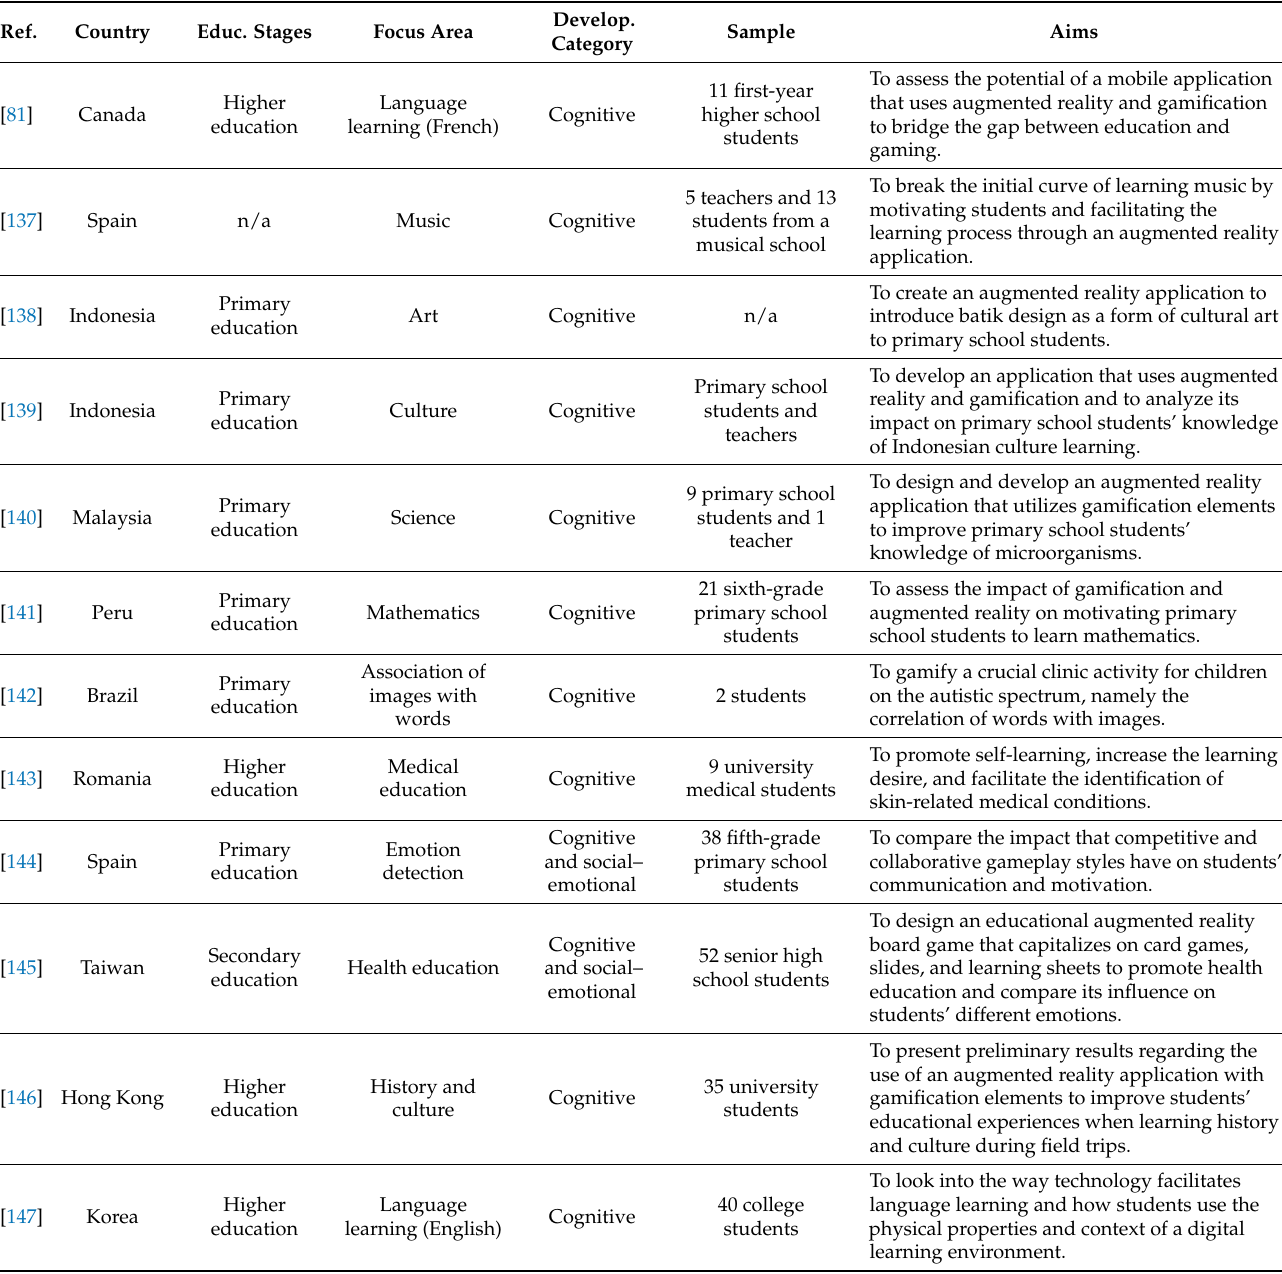
Table 1. Empirical studies: general